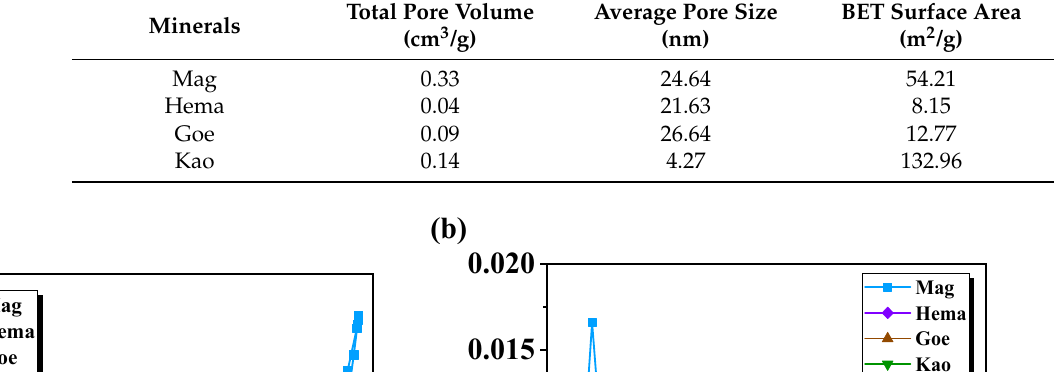
Table 1. BET analysis results of the iron-containing minerals. Minerals